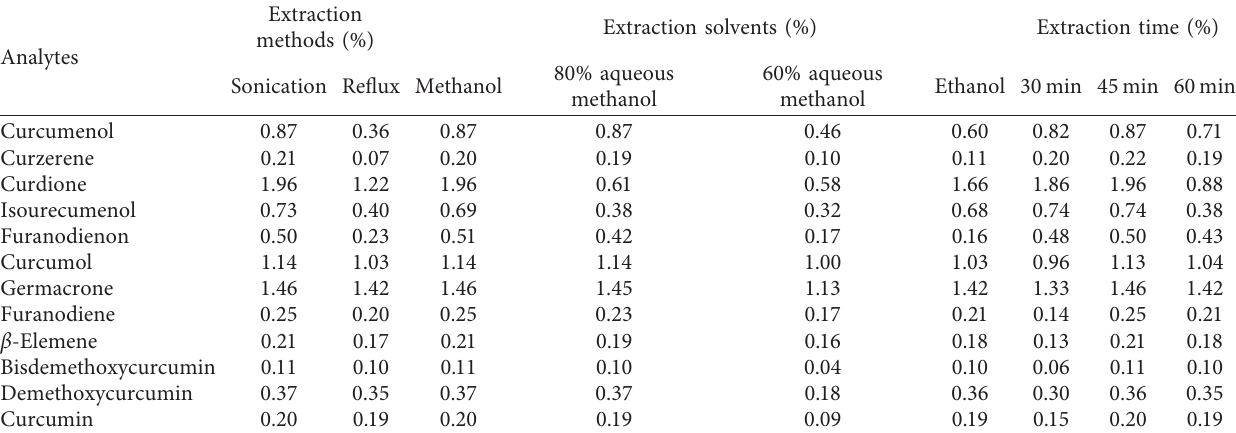
Table 1: Optimization of extraction